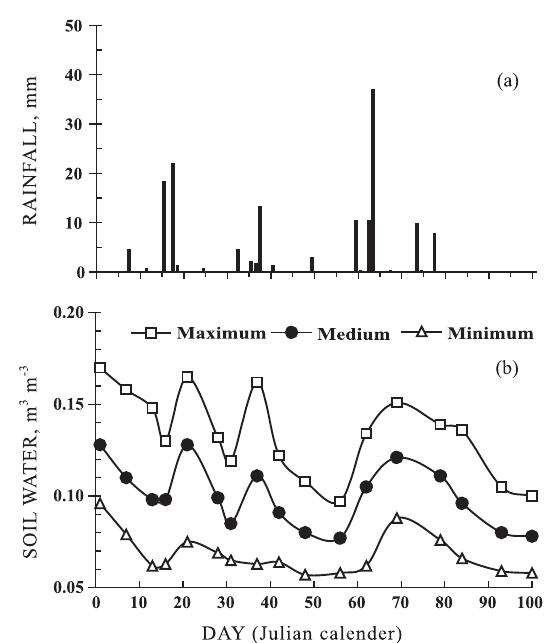
Figure 2. Rainfall (a) and soil water in the 0–20 cm layer (b) in the assessment period of 100 days (March 22 to June 27,